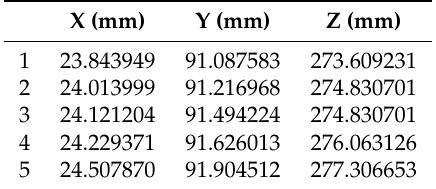
Figure 14. A set of QR code images acquired by the robot binocular vision system. ( a ) QR images obtained by left-hand side camera. ( b ) QR images acquired by the right-hand side camera. Table 4. X, Y, and Z coordinates of a point in base coordinate system, calculated five